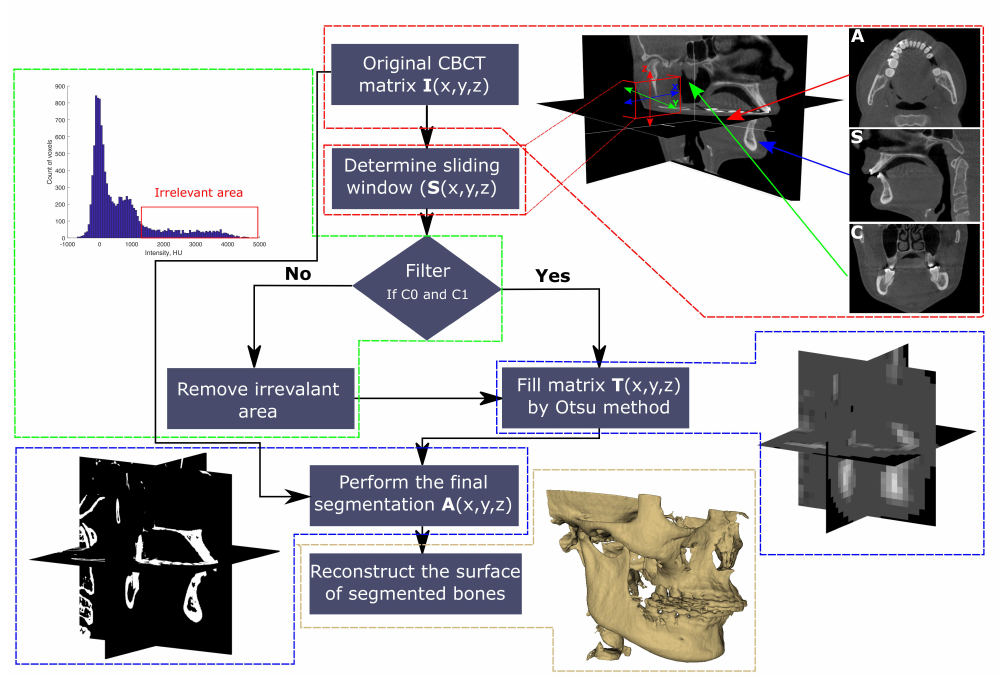
Figure 2. Implementation of segmentation by using the proposed automatic